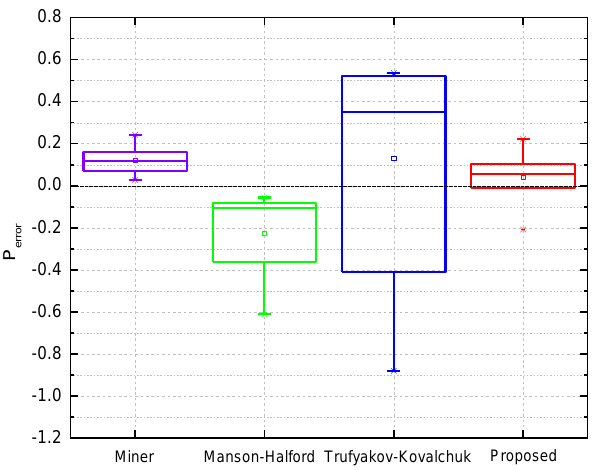
Figure 9. Model prediction errors of turbine blades.